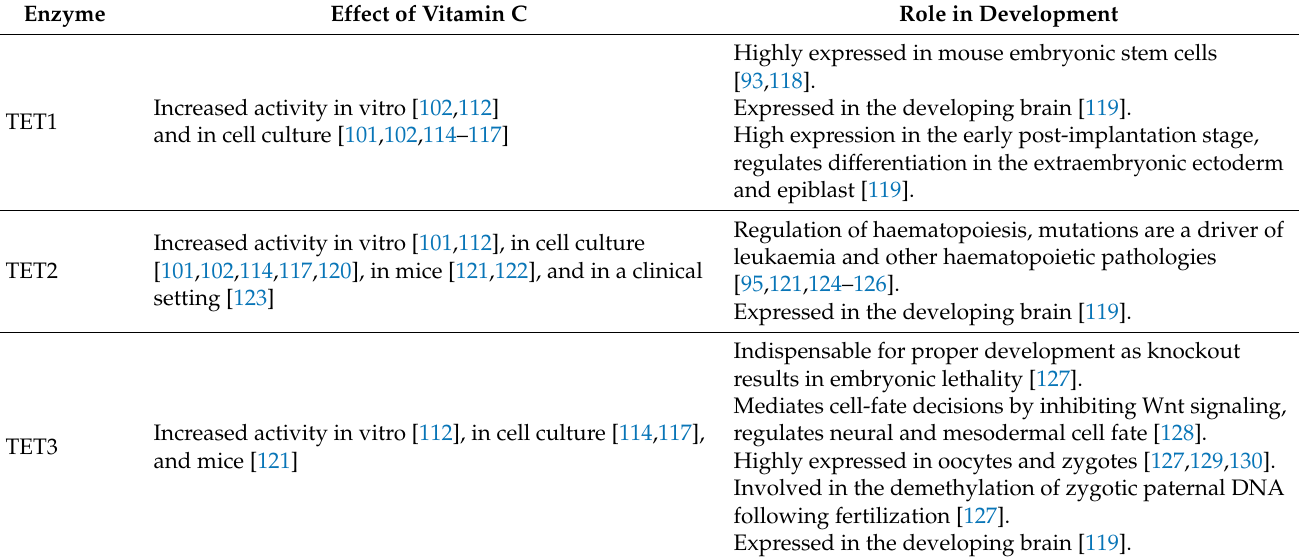
Table 1. The TET Enzymes, Their Dependency on Vitamin C, and Their General Role in